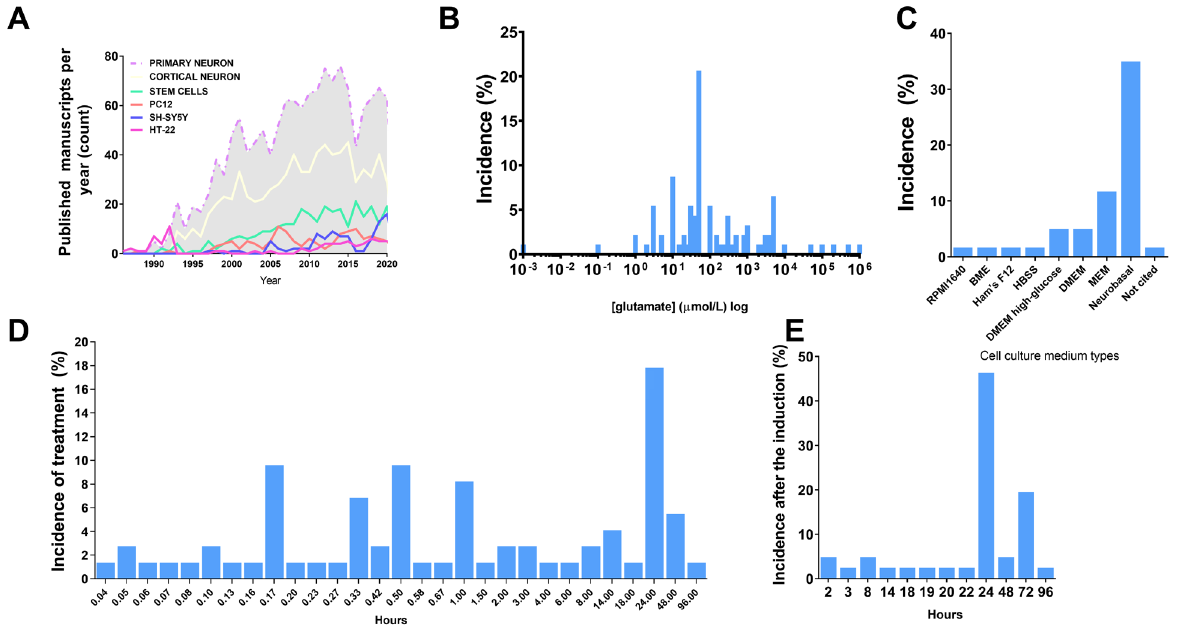
Figure 2. Excitotoxicity induction. A. Distribution of the amount of published studies over the years using different agonists in the excitotoxicity field. Data acquired through PUBMED search engine of indexed papers, following the request example “((excitotoxicity) AND (primary neuron)) NOT (review[Publication Type])”, “((excitotoxicity) AND (cortical neuron)) NOT (review[Publication Type])”, “((excitotoxicity) AND (stem cell)) NOT (review[Publication Type])”, “((excitotoxicity) AND (PC12)) NOT (review[Publication Type])”, “((excitotoxicity) AND (SH-SY5Y)) NOT (review[Publication Type])”, “((excitotoxicity) AND (HT-22)) NOT (review[Publication Type])”; B. distribution of agonist concentration incidence in published manuscripts regarding in vitro models (% of